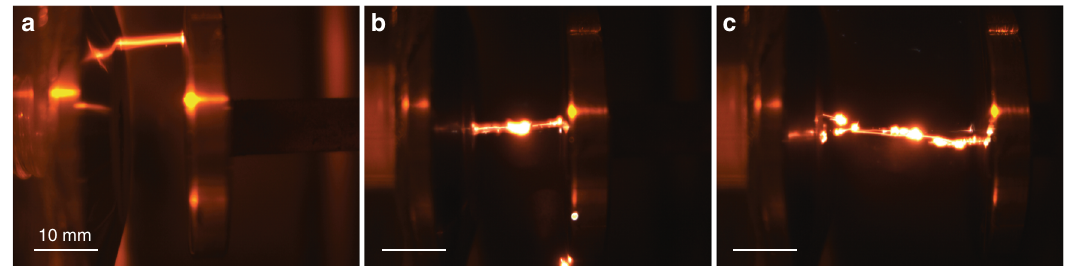
Fig. 5 Vortex beam guided electrical discharge with multiple trapped particles. a Demonstrate an electrical breakdown at standard conditions (32 kV and 10 mm distance) without trapped particles. b , c Demonstrate an observation of a guided electrical discharge with multiple trapped particles for 15 mm and 25 mm air gaps, power continuous wave operation ensures ease of implementation and paves the way for a range of applications such as controlling high voltage systems 1 , microfabrication and machining 3,4 , precision microsurgery and cancer treatment 8 – 12 , and controlling atmo- spheric lightning 2,33 .